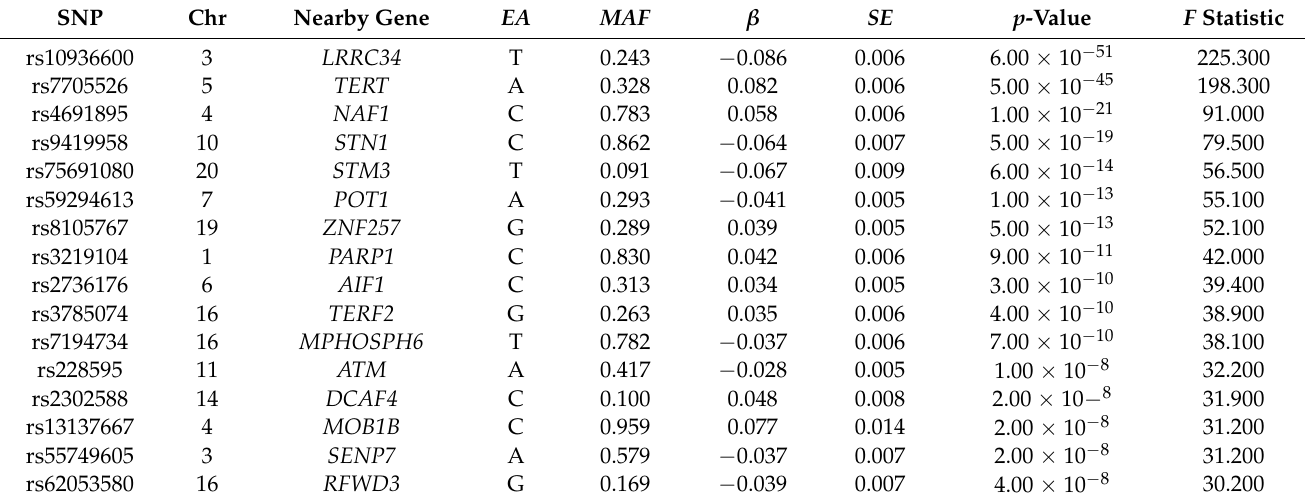
Table 1. Characteristics of SNPs predictive of telomere length